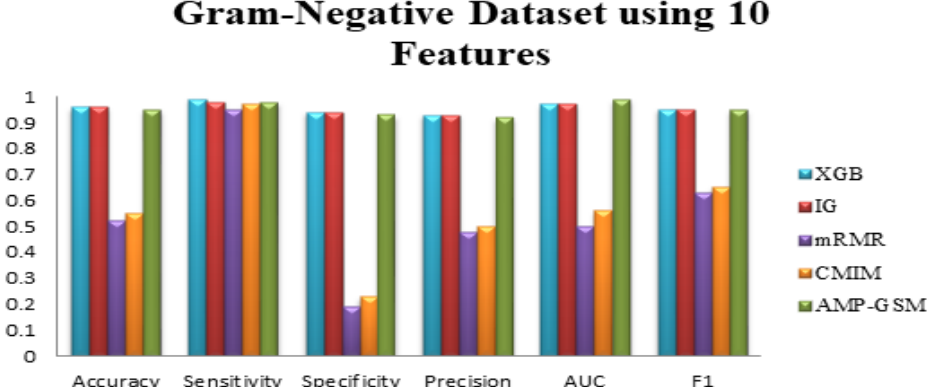
Figure 3. Performance evaluation of different feature selection techniques and the AMP-GSM approach on the Gram-negative dataset of Dataset 1 using 10 features and 100-fold MCCV. Table 6 . Performance metrics of di ff erent feature selection techniques with 10 features on the Gram-negative dataset of Dataset 1, using 100-fold MCCV *.